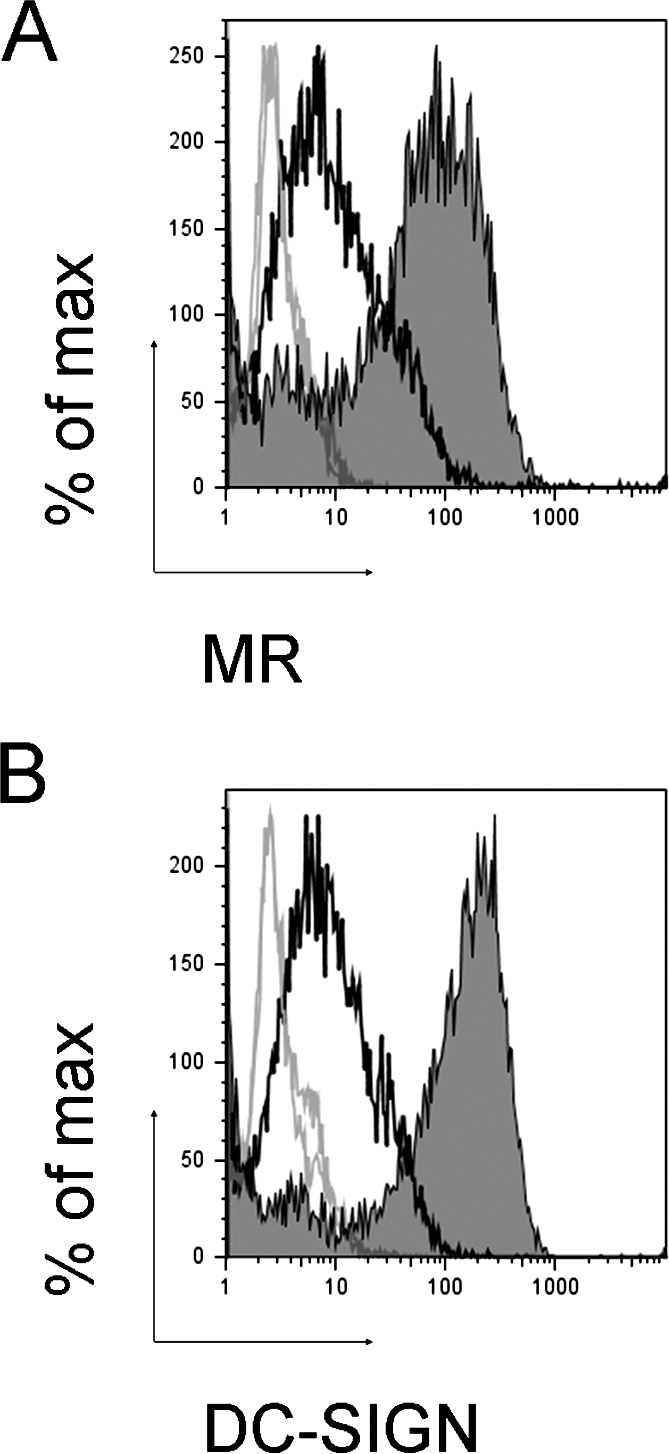
IL-4 Treatment Enhances Surface Expression of MR and DC-SIGN on Human MDMØThe effects of 2 d IL-4 treatment (25ng/ml) of human monocytes on surface expression levels of (A) MR and (B) DC-SIGN were assessed by flow cytometery. Receptor expression was detected with 15–2 (anti-hMR) or 120507 (anti-DC-SIGN) antibodies (black lines) on untreated cells (open histogram) and IL-4-treated cells (filled histogram). Matched isotype control (grey lines) staining is included. The relative fluorescence intensity was measured by FACSCalibur analysis and the data are normalised and presented as percent of maximum. Representative data from one of eight donors are shown.